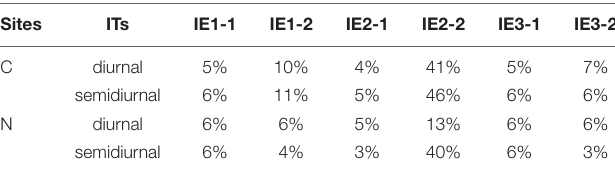
TABLE 3 | Vertical and temporal averaged incoherency of diurnal and semidiurnal internal tides (ITs) at sites C and N in all the experiments. Sites